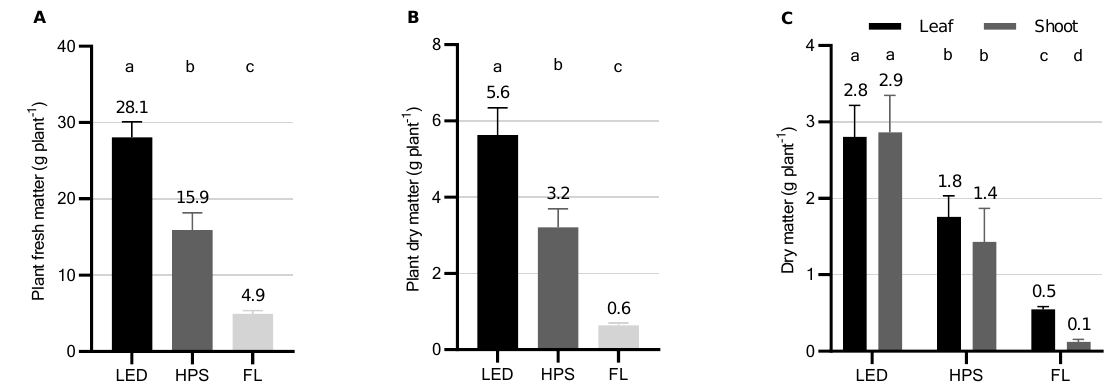
Figure 1. Biomass yields and partitioning of Thymus vulgaris L. cultivated under different supplemental lighting systems during fall and winter in Berlin, Germany. LED = light-emitting diode, HPS = high-pressure sodium lamp, FL = fluorescent light. A = Fresh matter yields in gram per plant*, B = Dry matter yields in gram per plant*, C = Leaf and shoot dry matter partitioning in gram per plant**. *Presented are mean plant yields of four independent spatial replications per light treatment ( n = 4) ± standard deviation (SD) of 32 harvested plants per spatial replication and light treatment (N = 384, n = 128 plants per supplemental light treatment, n = 32 plants per spatial replication). Significant differences ( p ≤ 0.01) were determined according to Dunnett’s T3 multiple comparisons test after Brown-Forsythe and Welch ANOVA test ( p ≤ 0.001). Different letters indicate significant differ- ences. **Presented are mean dry leaf and shoot matter yields of four independent spatial replications per light treatment ( n = 4) ± SD (standard deviation) of 16 harvested plants per spatial replication and light treatment (N = 192, n = 64 plants per supple- mental light treatment, n = 16 plants per spatial replication). Significant differences ( p ≤ 0.05) were determined according to Dunnett’s T3 multiple comparisons test after Brown-Forsythe and Welch ANOVA test ( p ≤ 0.001). Different letters indicate significant differences. Figure 2. Visual appearance of Thymus vulgaris L. at harvest cultivated under different supplemental lighting systems during fall and winter of Berlin, Germany. LED = light-emitting diode, HPS = high-pressure sodium lamp, FL = fluorescent light. The reason for the outstanding biomass accumulations and the concomitant rapid thyme development under the LED system is clearly found in the heightened DLI between 400 and 700 nm, as shown by the correlation coefficient of r = 0.97 (R 2 = 0.95). That increas- ing DLIs accelerate the development and growth of plants up to a certain point is well established [45,46]. The correlation of DLIs and plant growth is known to be linear be- tween each species-specific light compensation point and light saturation point [7].